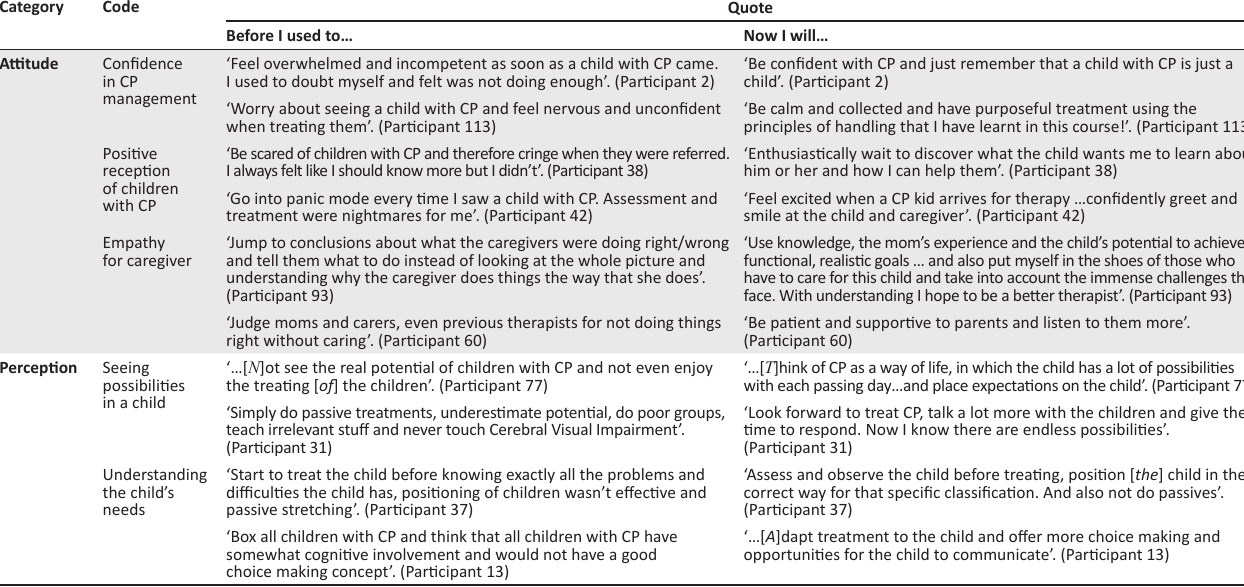
TABLE 4: Participants’ self-perceived change in attitude and perception towards children with cerebral palsy.